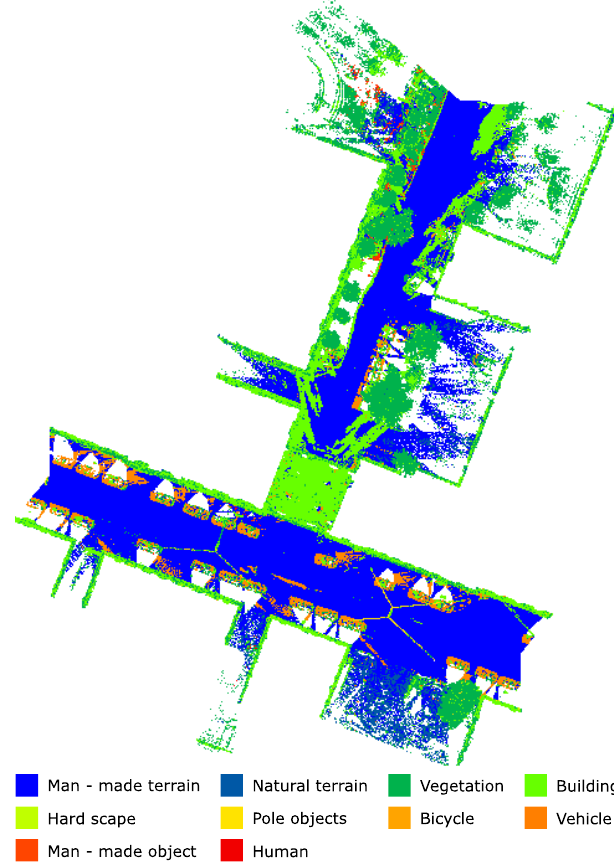
Figure 13. Final classification of Testset 2: nadir view